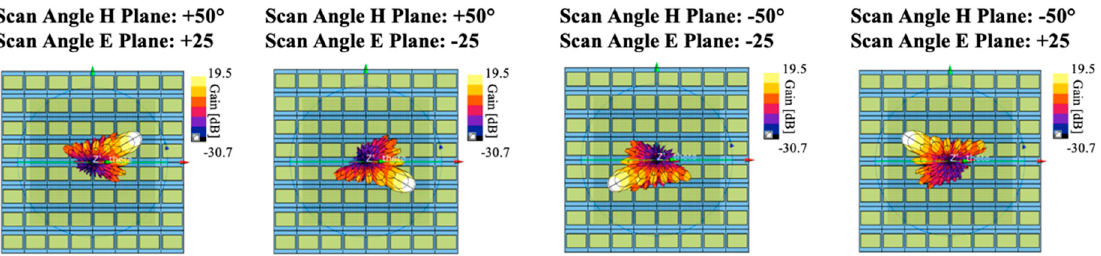
Figure 2. Gain radiation patterns of the UPA antenna at 3.7 GHz for four different configurations of the azimuth and elevation angles of beamforming direction.